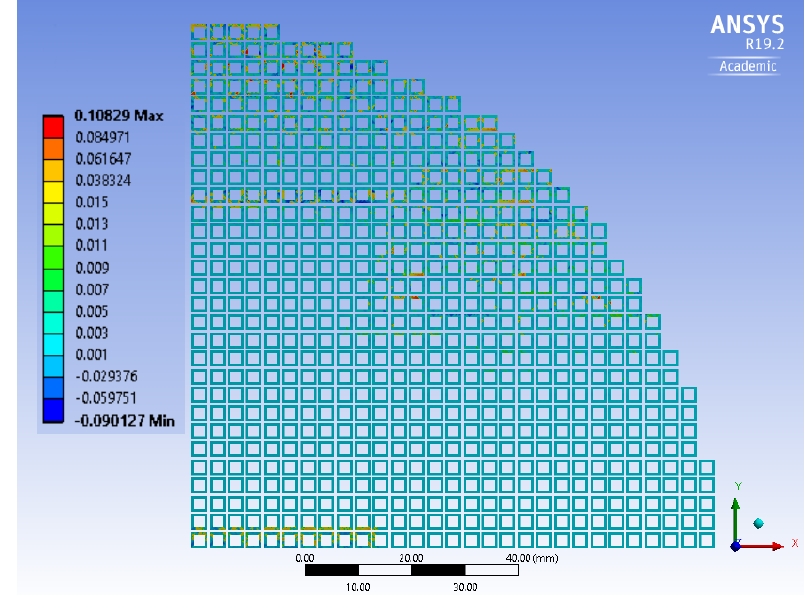
Figure 21. Tangential traction for interface elements (in